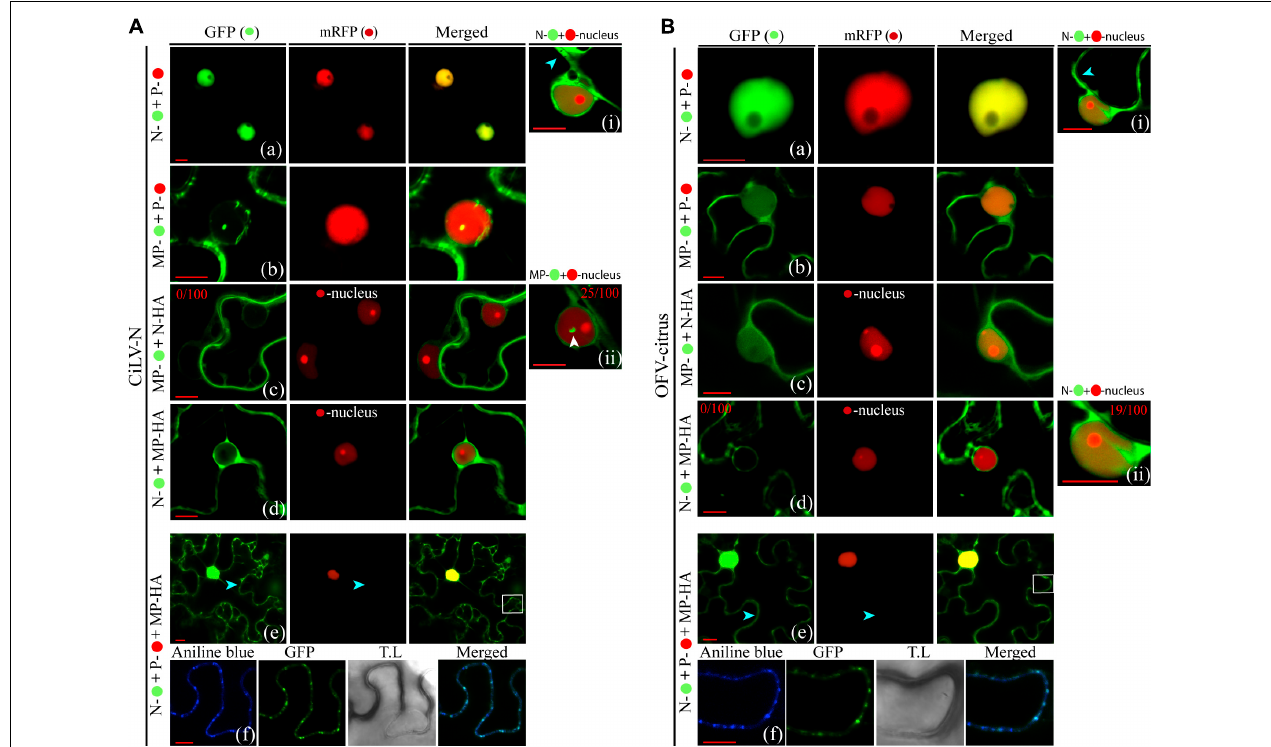
FIGURE 5 | Redistribution of the N protein from the N-P complex to the cell periphery and plasmodesmata upon co-expression with the MP. Confocal imagens of CiLV-N and OFV-citrus Ns- • , Ns-HA, Ps- • , MPs- • and MPs-HA transiently co-expressed in N. benthamiana leaves visualized at 48–72 h post-infiltration. The protein pair combinations performed among these constructions are: N- • + P- • (Aa,Ba) , MP- • + P- • (Ab,Bb) , MP- • + N-HA + • -nucleus marker (Ac,Bc) , N- • + MP-HA + • -nucleus marker (Ad,Bd) , and N- • + P- • + MP-HA (Ae,Be) . Blue arrows indicate GFP signal in the cytoplasm and white arrows indicate the GFP signal into the nucleus. The numbers at the top of Ai, Ac, Aii, Bd, and Bii panels corresponds the number of nuclei visualized expressing the correspondent protein fused to GFP from 100 counted nuclei. White boxes correspond to high magnification to highlight callose deposits stained with aniline blue ( • ) along the cell periphery (Af,Bf) . All images displayed are representative of at least three independent experiments. Bars correspond to 10 µ